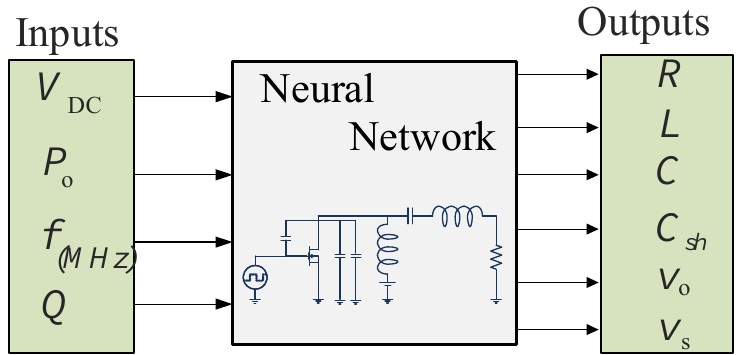
Figure 3. The proposed ANN model for modeling of the class ‐ E amplifier.